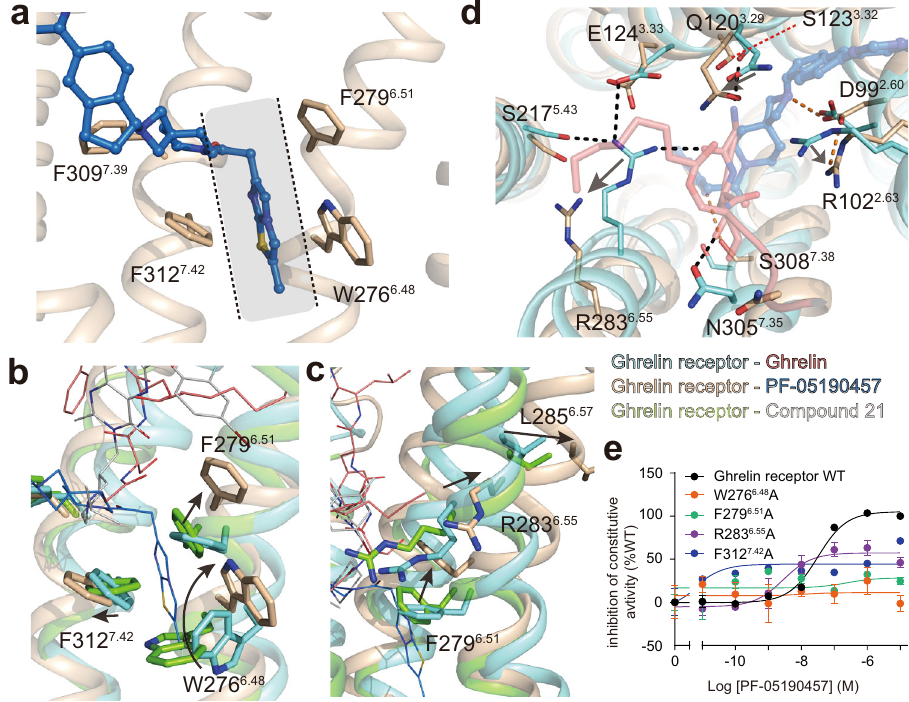
Fig. 5 Detailed mechanism of inverse agonism action on the ghrelin receptor. a The arm-2 group of PF-05190457 was observed to insert into the core of the receptor and was sandwiched by side chains from the hydrophobic cluster W276 6.48 -F279 6.51 -F312 7.42 (WFF cluster). b Superposition of PF- 05190457-bound (wheat cartoon) and ghrelin-bound (aquamarine cartoon) structures shows that the WFF cluster exhibits obvious conformational displacements upon inverse agonist binding. c , d The inverse agonist PF-05190457 pushes outward movements of the extracellular end of TM6 ( c ), destroying the key polar interactions involved in activation ( d ). The polar networks are shown as black dotted lines (ghrelin-bound) and orange dotted lines (PF-05190457-bound). e Mutations of W276 6.48 , F279 6.51 , and F312 7.42 in the ghrelin receptor signi fi cantly reduced the potency of inverse agonism. Data represent the mean ± SEM from n = 3 biologically independent experiments performed in triplicate. See also Supplementary Fig.